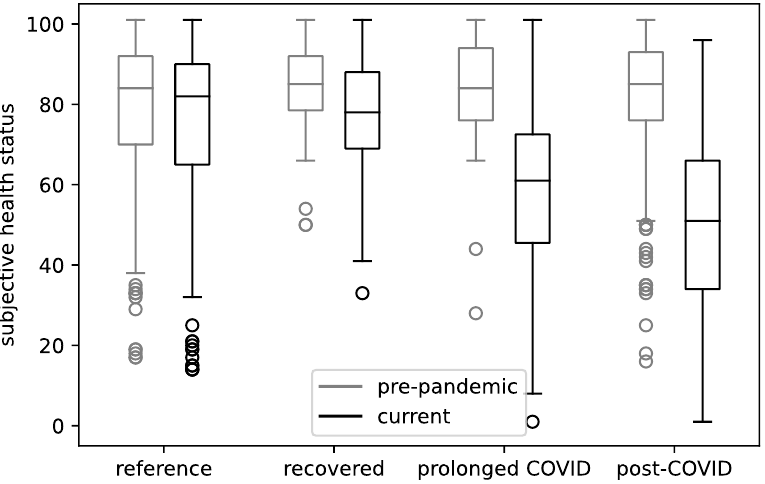
Figure 2. Assessment of health status before the pandemic and now.